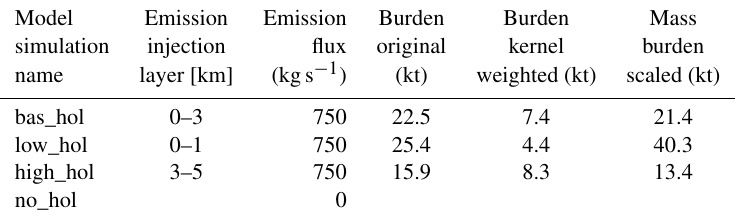
Table 1. Overview of model runs and the Holuhraun SO 2 emission height assumptions and flux; given are also medians of daily mass burdens of SO 2 for September to October 2014 in the North Atlantic as described along with Figs. 2 and 3.; last column contains scaled mass burdens, assuming 7.0kt of SO 2 burden derived from satellite data (see text in